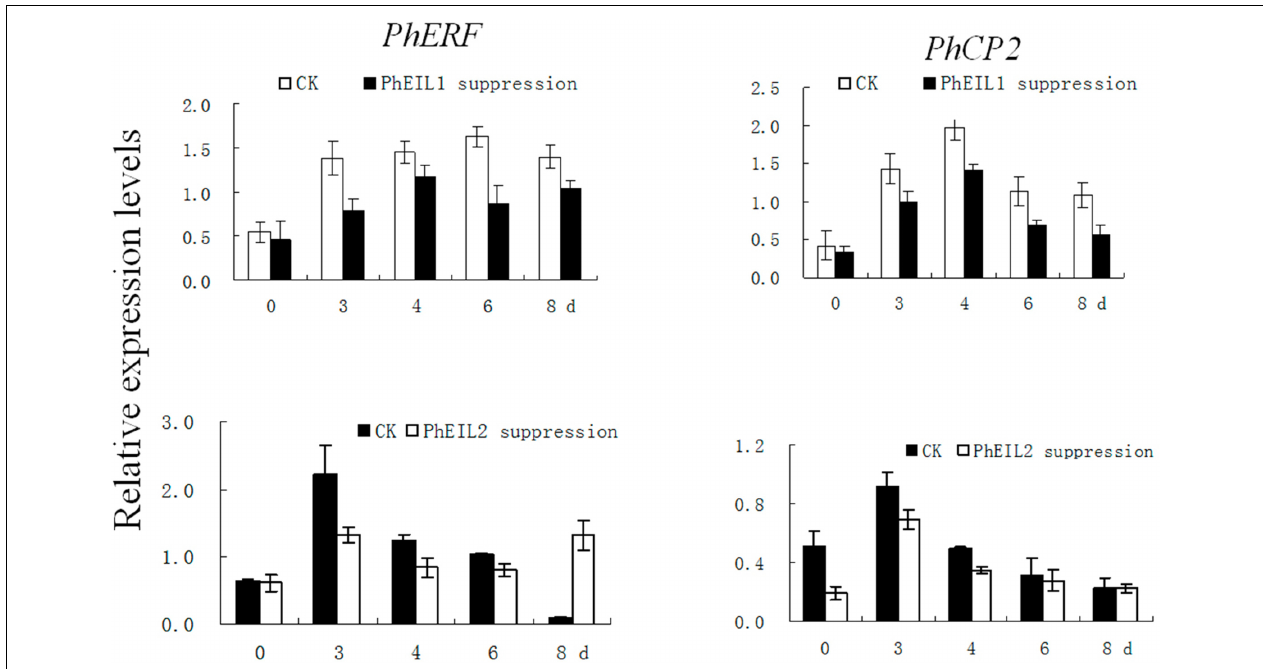
FIGURE 5 | Effects of PhEIL1 and PhEIL2 silencing on the expression of PhERF3 and PhCP2 in flowers. Flowers were detached on the day in anthesis. Total RNA was isolated from white flower tissues. PhERF3 and PhCP2 mRNA levels were determined by quantitative real-time PCR. Relative expression levels are shown as fold change values. Data are the mean ± SD ( n = 3). Statistical analysis was performed using one way analysis of variance (ANOVA) followed by Duncan’s multiple range test (DMRT) with three replicates. P -values ≤ 0.05 were considered as significant.